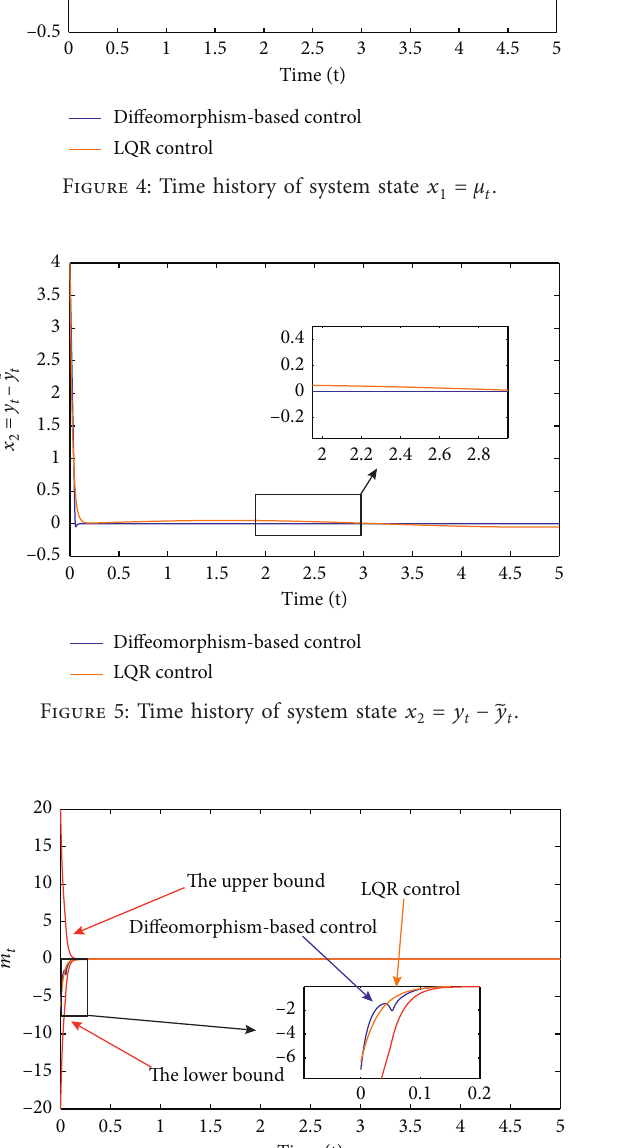
Figure 6: Time history of actual control m